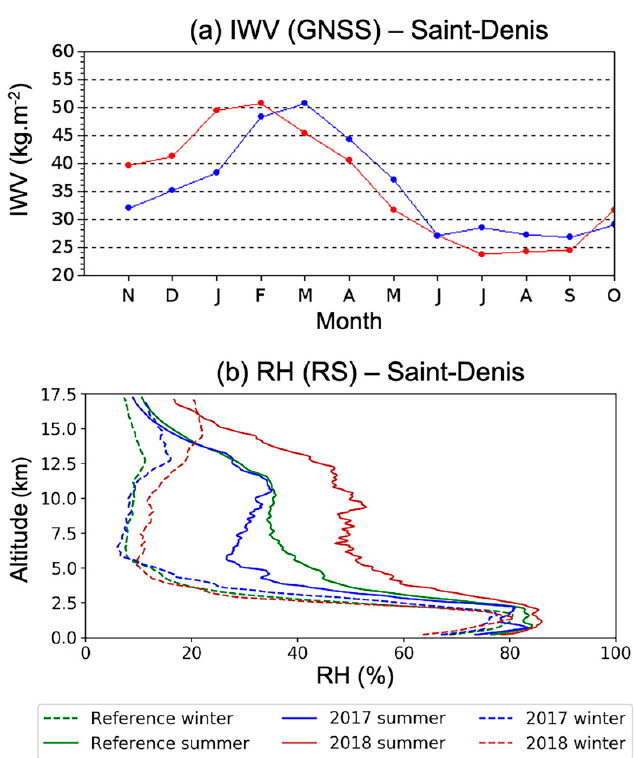
Figure 9. ( a ) Monthly mean of GNSS ‐ derived IWV content at station REUN in 2017 (blue) and 2018 (red). ( b ) RS ‐ derived relative humidity at Saint ‐ Denis during summer (plain) and winter (dashed) 2017 (blue) and 2018 (red). The green line in ( b ) shows corresponding average RH profiles for the period 2014–2018.